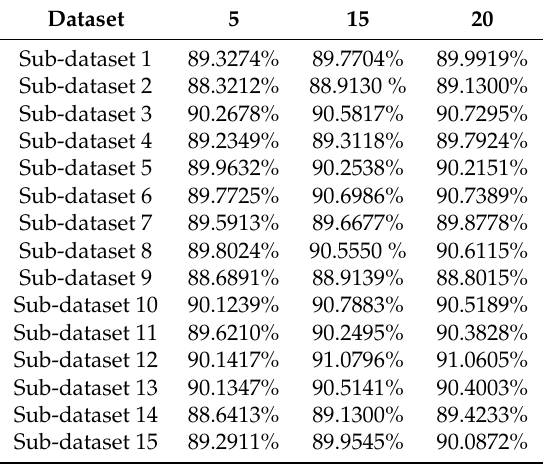
Table 6. Accuracy results of RSL-KNN under multi-class classification.